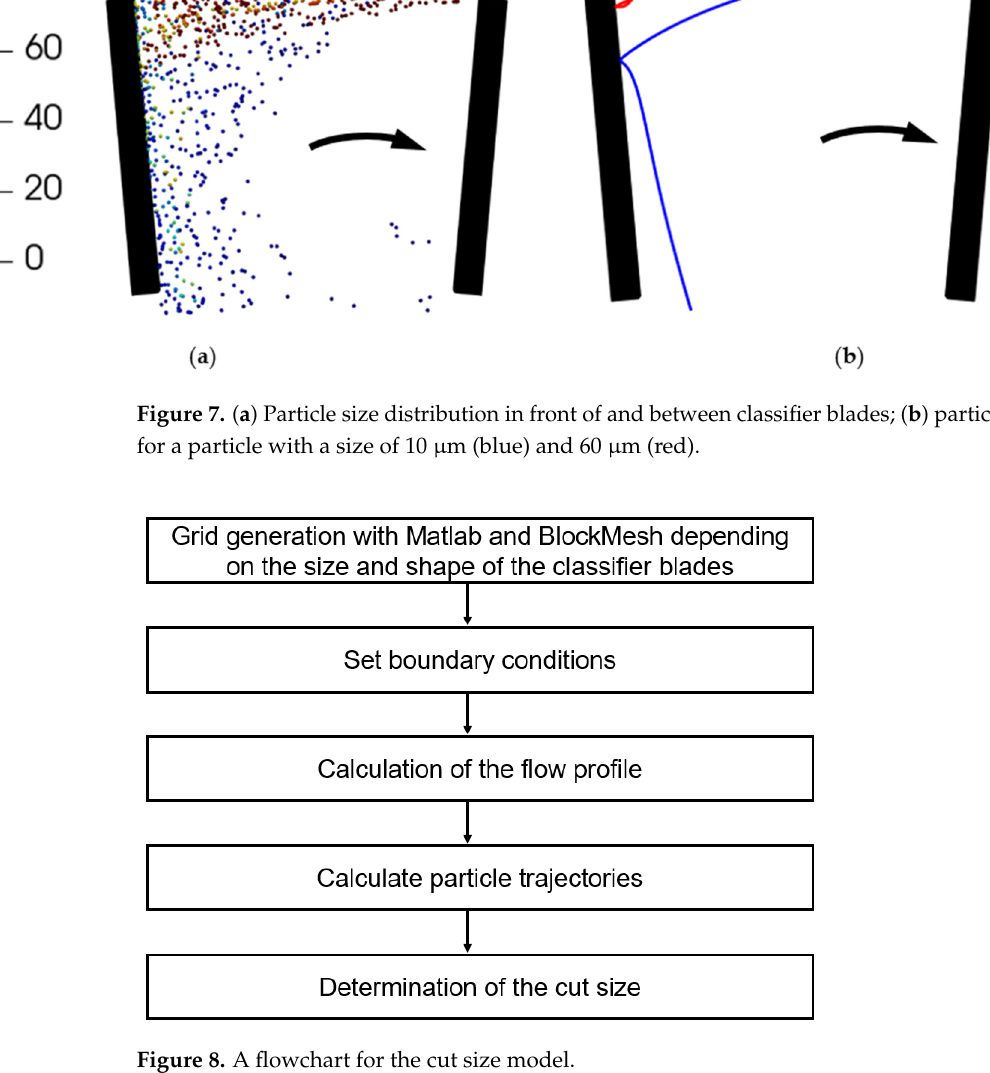
Figure 7. ( a ) Particle size distribution in front of and between classifier blades; ( b ) particle trajecto- ries for a particle with a size of 10 μ m (blue) and 60 μ m (red).